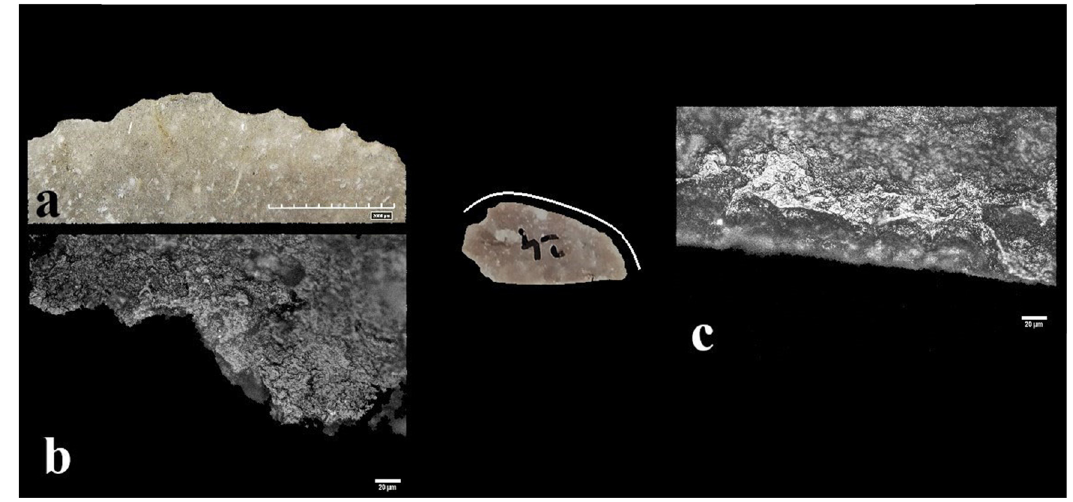
Figure 11: ( a ) Macro traces, ( b ) micro polish, and ( c ) micro polish, detail ( photo by A. Petrovi ć ) .